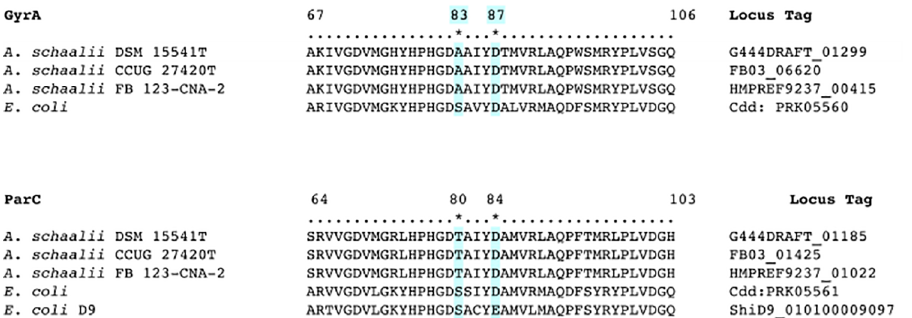
Fig 5. Comparison of the amino acid sequences of the QRDRs of both GyrA and ParC in A . schaalii with the equivalent region of E . coli . Hotspots for mutation giving rise to fluoroquinolone resistanceare at serine 83 and aspartate 87 of the GyrA and at serine 80 and aspartate84 of ParC (according to E . coli numbering).